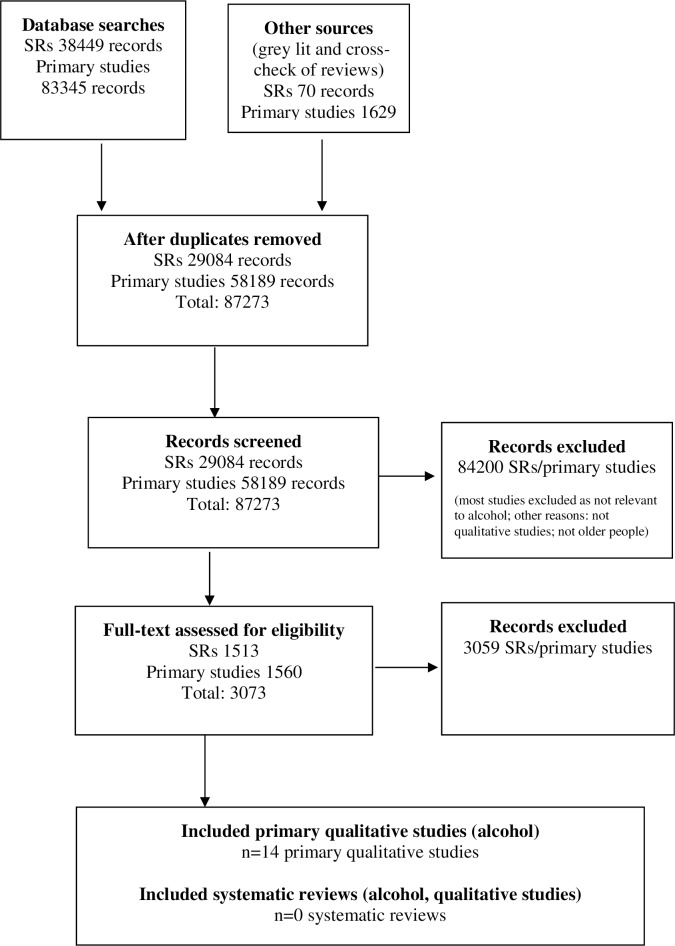
PRISMA flow diagram.